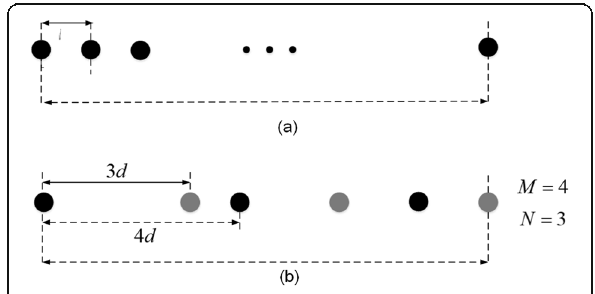
Fig. 4 Comparison of uniform and co-prime arrays. a Uniform linear array formed by 9 elements. b Co-prime array formed by 6 elements. It compares the uniform array with the non-uniform array, showing the advantages of the